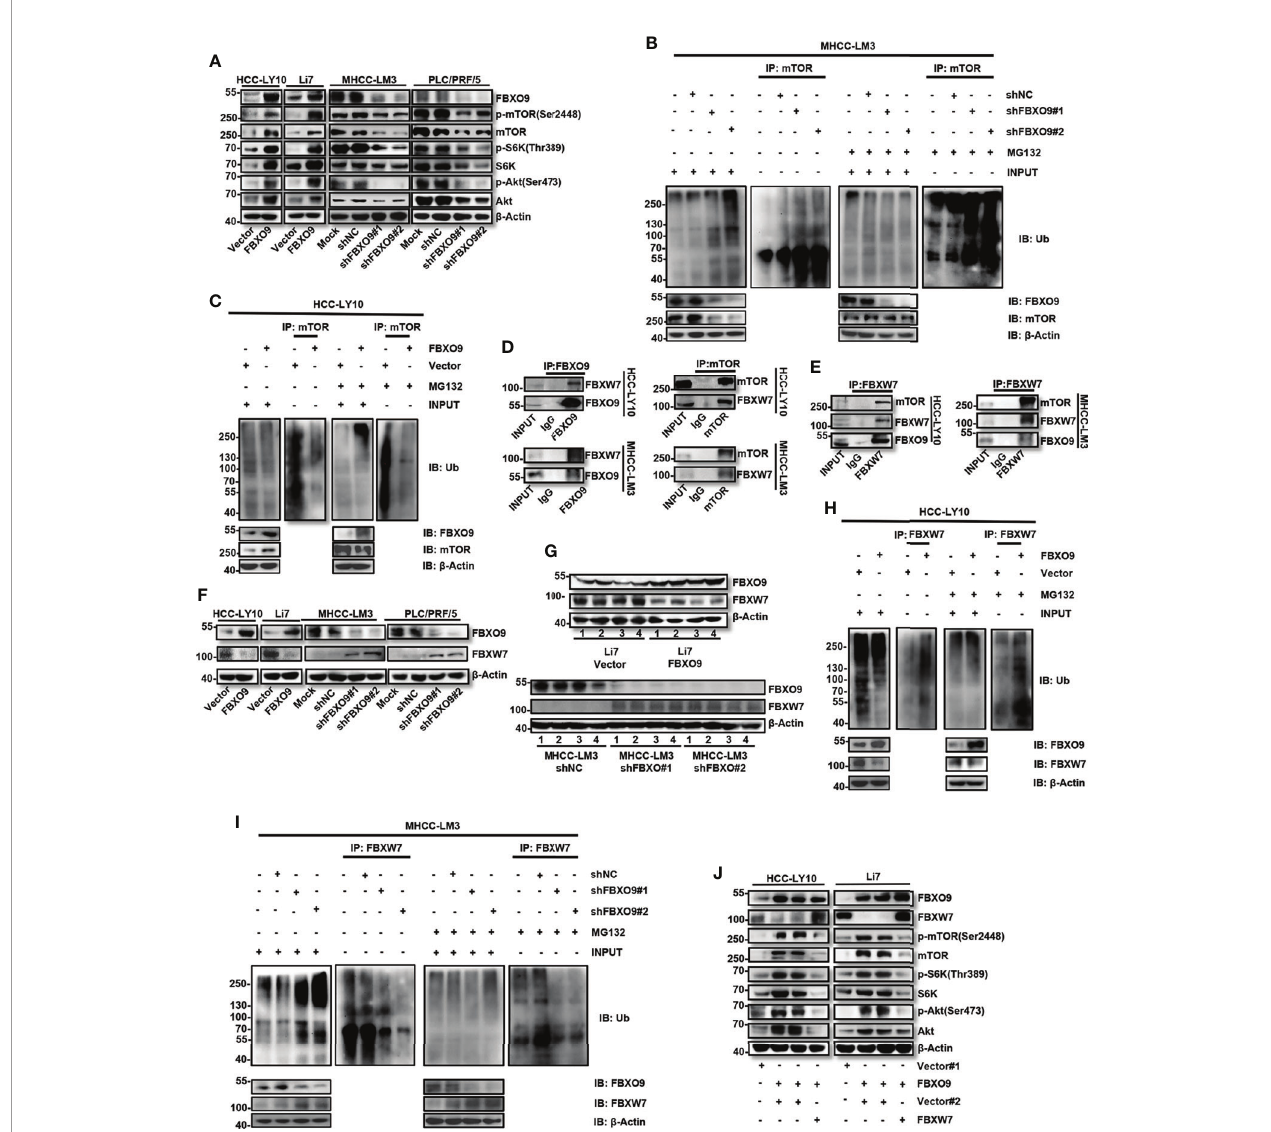
FIGURE 5 | FBXO9 exerts its cancer-promoting effect by interacting with FBXW7 and promoting ubiquitination and degradation of FBXW7 in HCC. (A) Western blotting of the levels of p-mTOR, p-S6K, p-Akt, total mTOR, S6K, Akt, and FBXO9 in HCC cells with FBXO9 overexpression or knockdown. (B, C) HCC cell with FBXO9-overexpressing or FBXO9-knockdown were treated with 10 m M MG132 or DMSO for 6 h, lysates were immunoprecipitated with an anti-mTOR antibody under native conditions. The resultant immunocomplexes and lysates (Input) were immunoblotted with antibodies against indicated antibodies. (D, E) Endogenous FBXO9, mTOR, or FBXW7 were immunoprecipitated with antibodies as indicated. The proteins in immunocomplexes were respectively detected using anti-FBXO9, anti-FBXO9, or anti-FBXW7 antibody by western blotting. (F, G) Western blotting of the protein levels of FBXO9 and FBXW7 in FBXO9-overexpressing or knock down HCC cells or xenograft tumors. (H, I) HCC cell with FBXO9-overexpressing or FBXO9-knockdown were treated with 10 m M MG132 or DMSO for 6 h, lysates were immunoprecipitated with an anti-FBXW7 antibody under native conditions. The resultant immunocomplexes and lysates (Input) were immunoblotted with antibodies against indicated antibodies. (J) Western blotting showed the protein levels of FBXO9, FBXW7, p-mTOR, p-S6K, p-Akt, total mTOR, S6K, and Akt in FBXO9-overexpressing HCC cells after